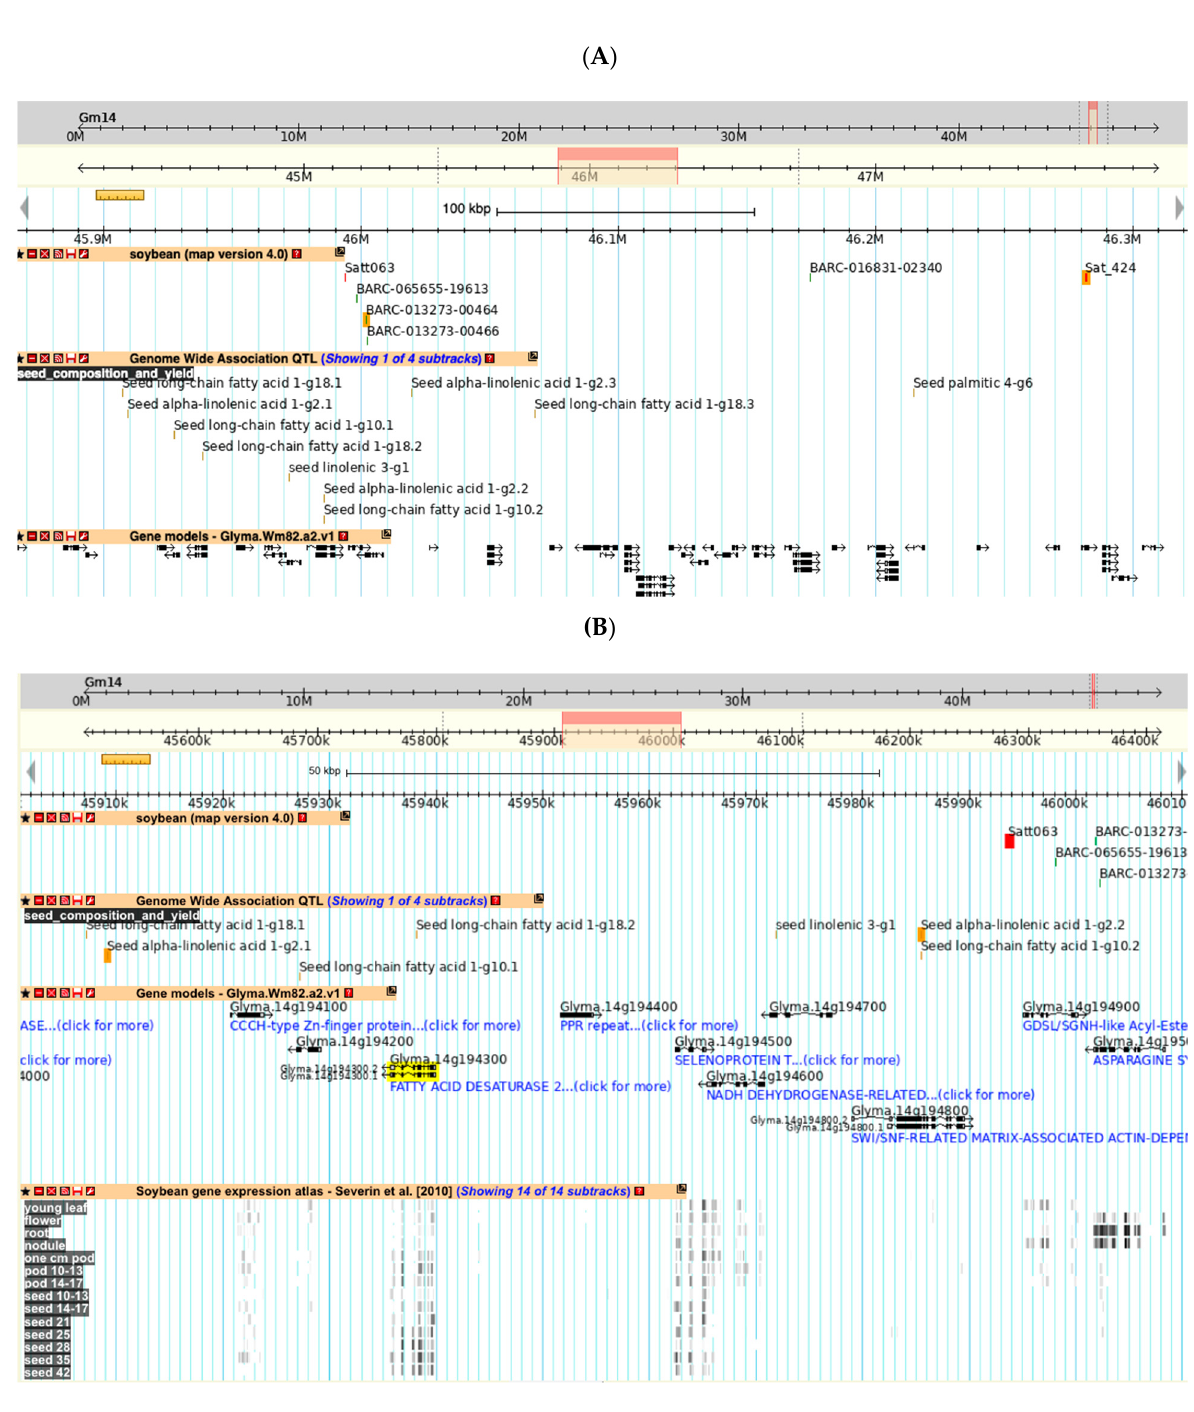
Figure 4. Identification of a candidate gene using the SoyBase Genome Browser. The region of the soybean physical map around Seed linolenic 11-2. ( A ) Magnification of the genomic region around Satt063. Molecular markers that flank Seed linolenic 11-2 are highlighted in orange. Tracks are also shown for GWAS QTL and genes. Larger version ( B ) Magnification of the chromosomal region in Panel A showing the short functional annotation for genes. The candidate gene Glyma.14g134300 is highlighted in yellow. The flanking GWAS QTL (orange) are indicated in the Genome Wide Association QTL track. Gene expression patterns indicating that the highlighted gene is preferentially expressed in seed tissue derived from RNA-seq are shown in the bottom track. Larger version .